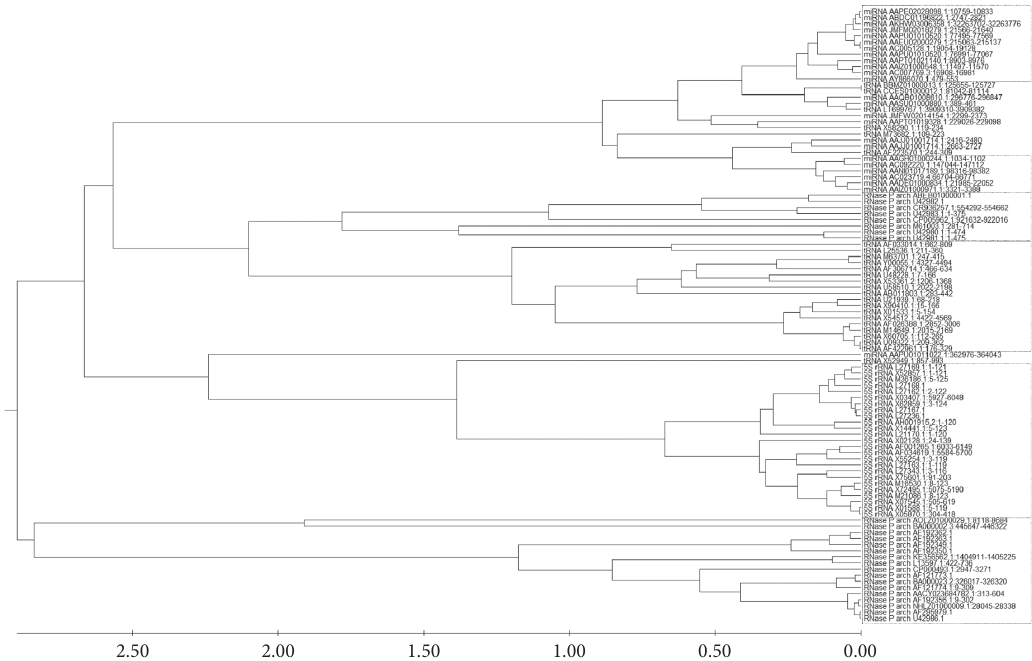
Figure 8: The cluster analysis graph of 100 noncoding RNA sequences generated by our method. Table 5: The Pearson correlation efficiency between the cluster analysis graphs generated by the different methods and those generated by MEGA software.